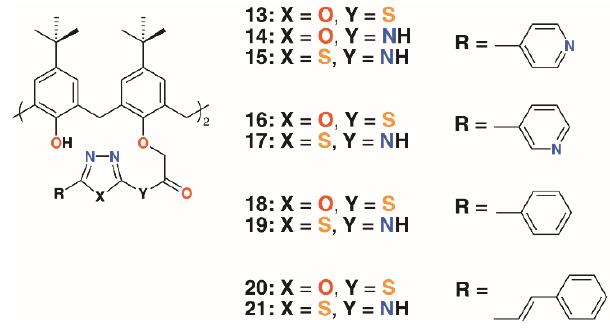
Figure 6. Menon’s’ calixarene prodrugs.